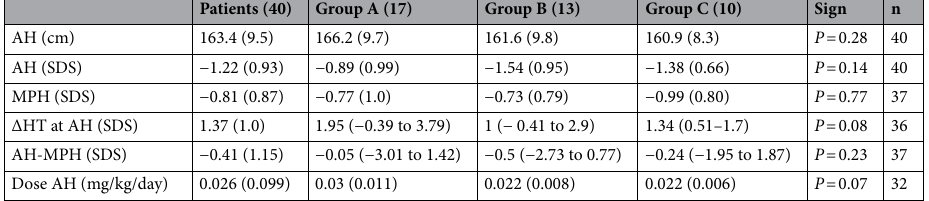
Patients (40) Group A